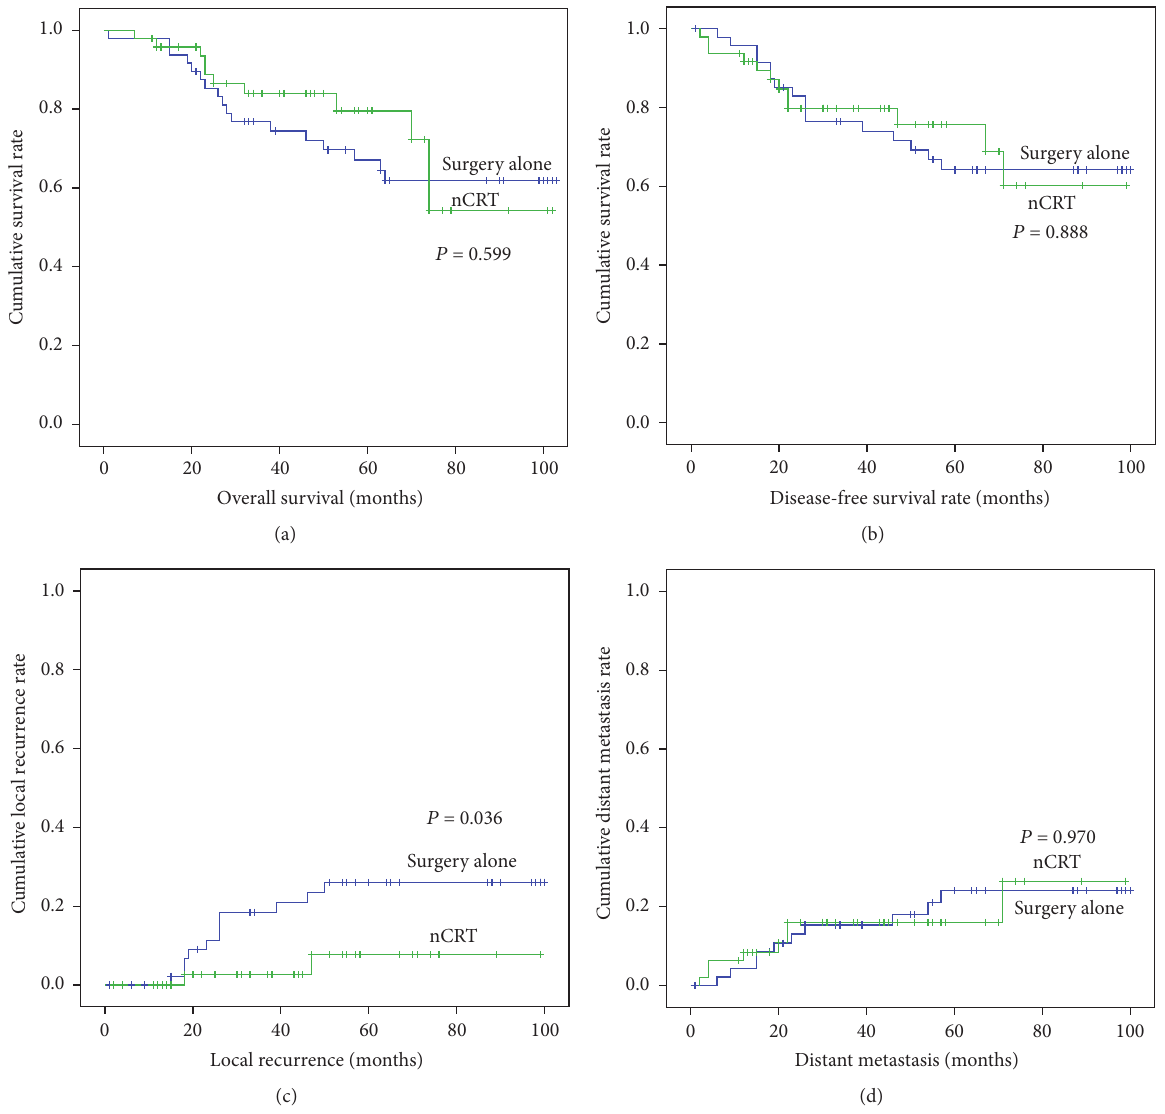
Figure 1: (a) Overall survival, (b) disease-free survival, (c) cumulative local recurrence, and (d) cumulative distant metastasis rate between nCRT group and surgery-alone group. nCRT: neoadjuvant